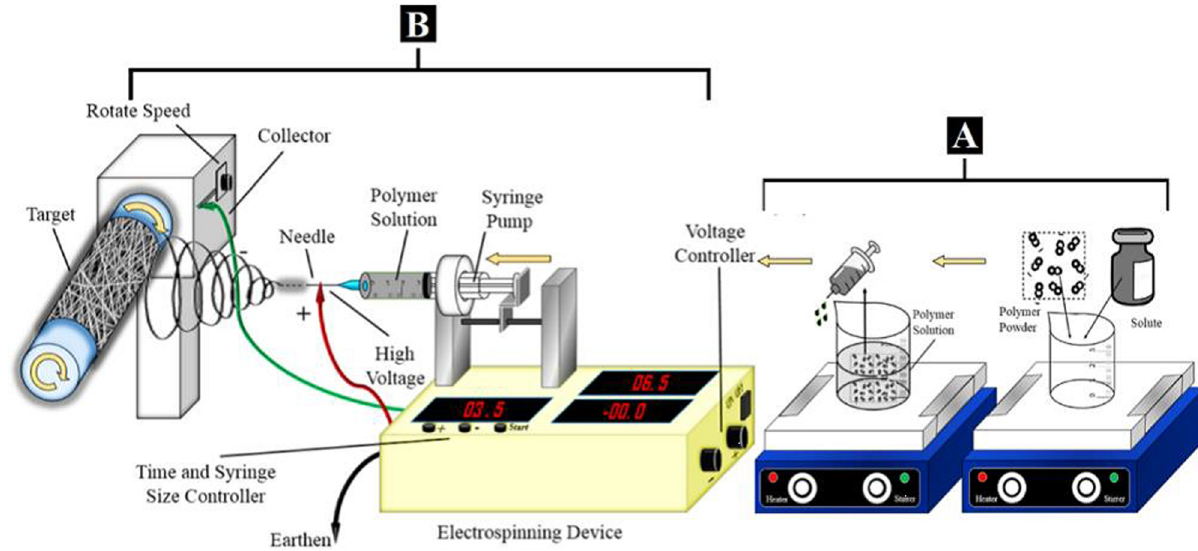
Figure 1: Electrospinning process: ( A ) homogeneity process using magnetic stirrer, ( B ) Electrospinning set up [ 16 ]